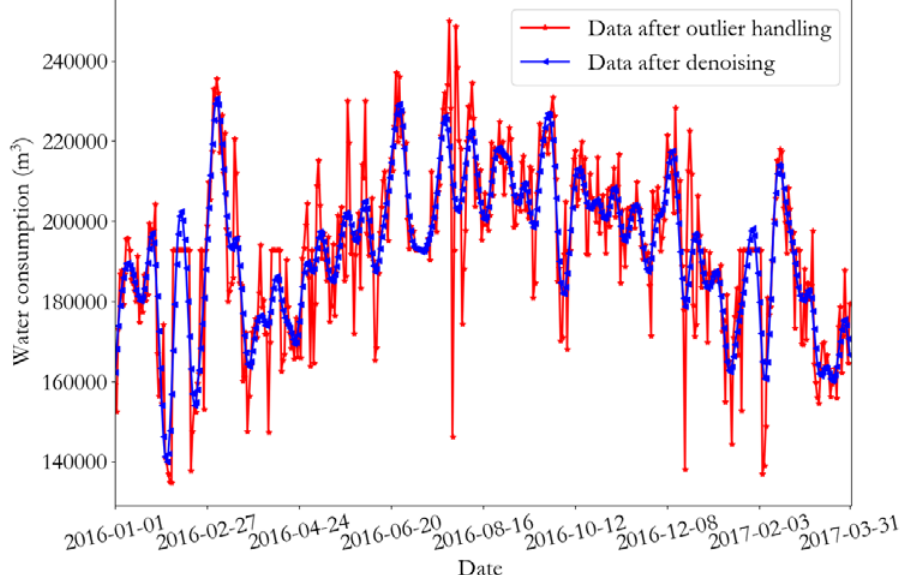
Figure 5. Data after removing outliers and after de-noising of the monitoring point 2.